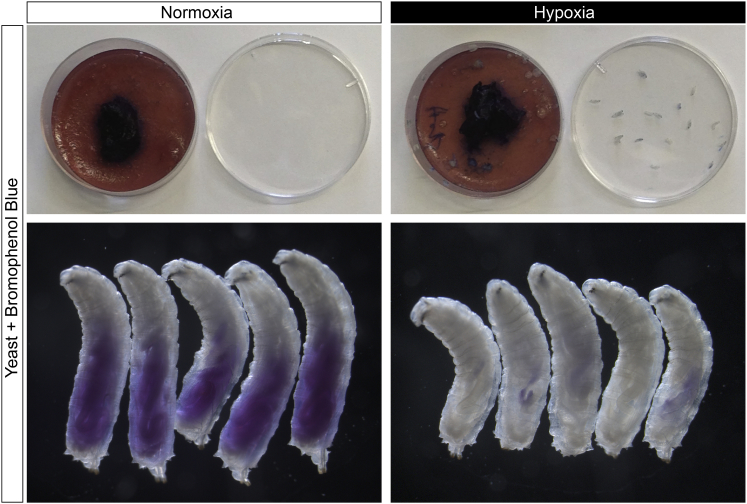
Hypoxia Inhibits Larval Food Intake, Related to Figure 1Top panels show petri dishes containing colored food (yeast paste containing bromophenol blue) and their corresponding lids. Petri dishes contained mid-third instar larvae subject to normoxia (20.9% oxygen, left panels) or hypoxia (2.5% oxygen, right panels) for 2.5 hr. Bottom panels show high magnification views of larvae exposed to normoxia (left panels) or hypoxia (right panels) at the end of the experiments. Under normoxia, larvae remain in the food and ingested food is clearly visible in the gut. In contrast, hypoxia induces larvae to crawl out of the food and to ingest very little.